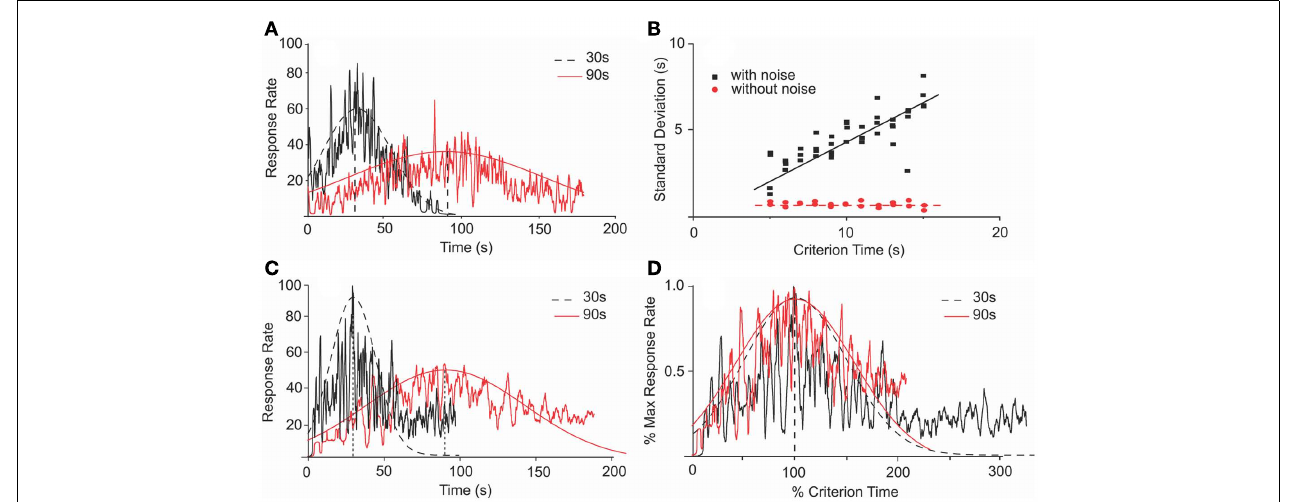
for the linear regression (dashed line) was r = 0.98 with a p -value less than 0.0001. (C) Numerical simulations of an SBF–ML model with normally distributed variability for both the criterion time and both within- and between-trials variability in frequencies generate response functions (jagged traces) with Gaussian-like envelopes (smooth curves).The only noticeable difference when adding within-trial frequency variability is the occurrence of the skewness in the response rate at late times. A similar skewness was observed in the behavioral data (see Figure 1 ) (D) The Gaussian envelopes for the case of criterion time variability (A) are given by Gauss (30, 21s), respectively, Gauss (90, 60s).They overlap when normalized in amplitude and in time.